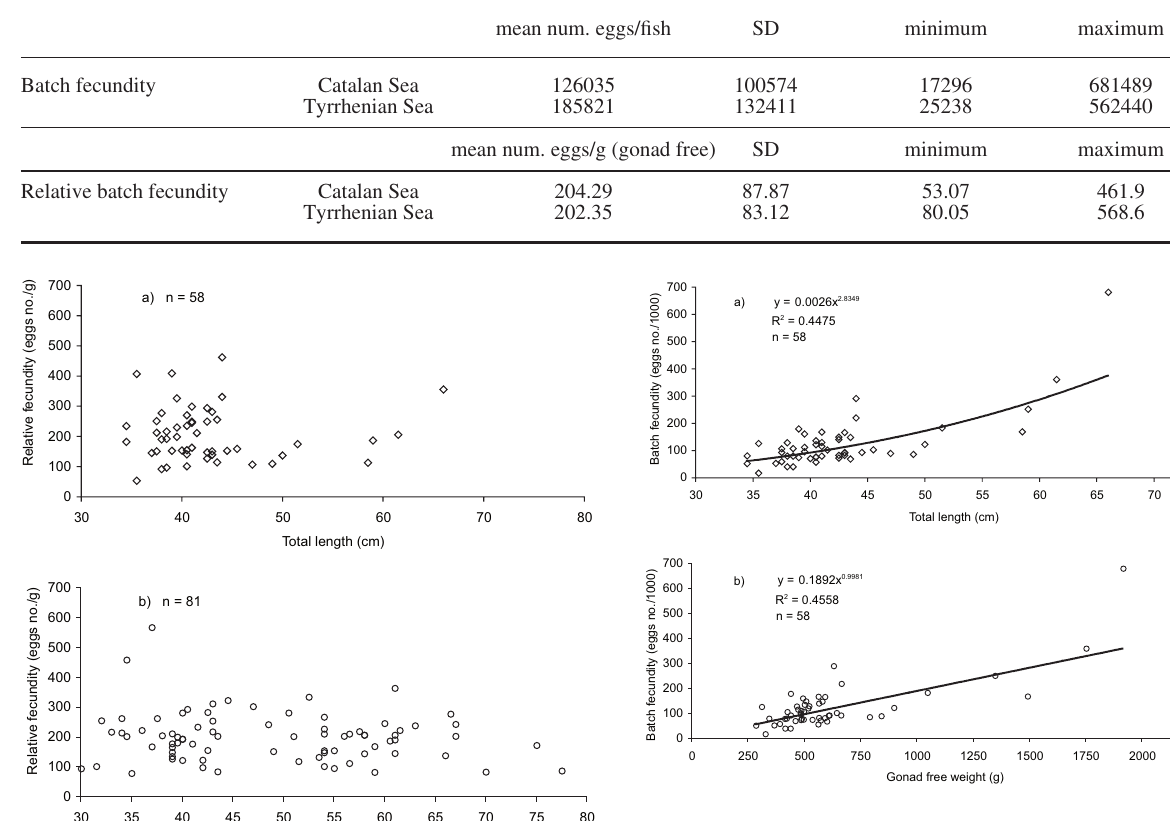
Fig . 11. – Catalan Sea. Relationships between batch fecundity (eggs number/female) and a) total length (cm); b) female gonad-free weight (g). Number of females =